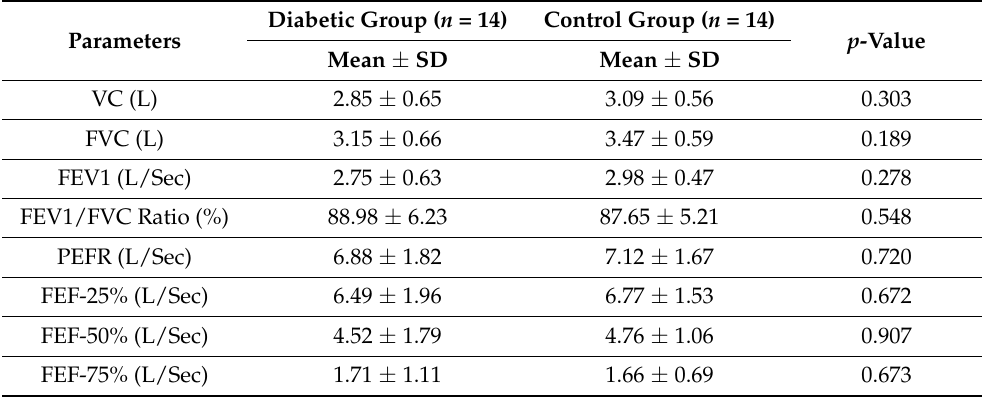
Table 2. Lung function parameters for type 2 diabetic patients with duration of the disease up to five years compared with their matched controls.